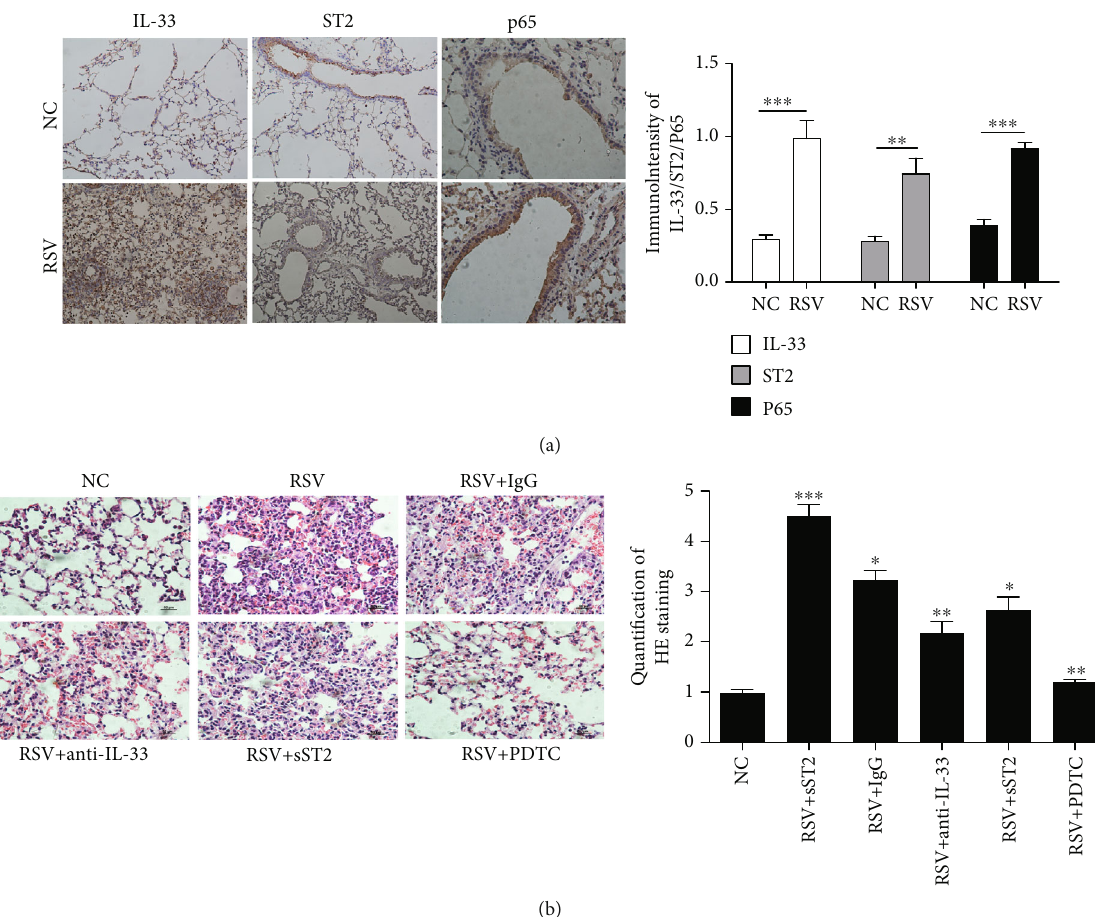
Figure 3: RSV-induced mouse model is attenuated after inhibition of NF- κ B/IL-33/ST2 pathway. (a) Immunohistochemical analysis of IL-33, ST2, and p65 abundance in saline-exposed control mice (NC); RSV-treated mice (RSV) was performed (original magni fi cation × 400, scale bar 100 μ m) and scored (right graph). (b) H&E staining of lung tissue in di ff erent group mice was analyzed by Image-proplus 6.0 (original magni fi cation × 400). The data are presented as mean ± SEM and were analyzed by Student ’ s t -test (NC group, n = 8 ; RSV group, n = 7 ; RSV + IgG = 6 ; RSV + IL − 33 antibody = 6 ; RSV + PDTC = 7 ; RSV + sST2 = 8 ). Each value of ∗ p < 0 : 05 , ∗∗ p < 0 : 01 , and ∗∗∗ p < 0 : 001 was considered to be signi fi cant di ff